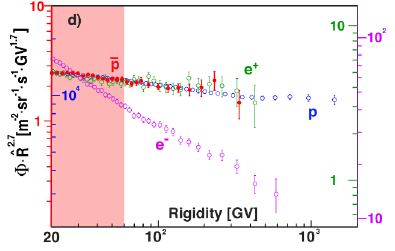
Figure 5. AMS measurements of the fl uxes of elementary par- ticles. The positron, antiproton and proton fl uxes show the very same functional behavior in the absolute rigidity range 60–500 GV, whereas electrons exhibit distinctly di ff erent